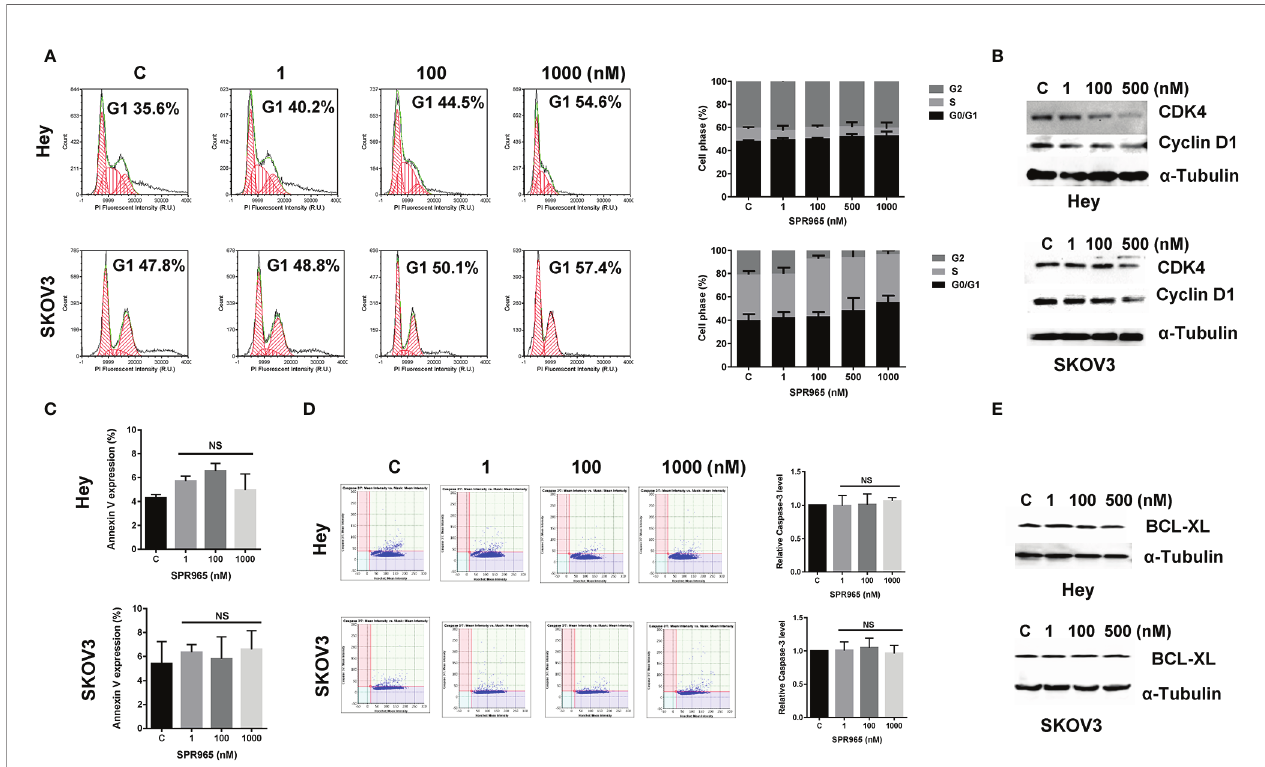
FIGURE 2 | Effect of SPR965 on cell cycle and apoptosis in ovarian cancer cells. The Hey and SKOV3 cells were treated with the indicated doses of SPR965 for 24 h. Cell cycle progression was assessed by Celigo Image Cytometer. SPR965 induced cell cycle arrest in G1 phase in the Hey and SKOV3 cells (A) . Cell lysates from the Hey and SKOV3 cells were subjected to Western blotting analysis for the expression of CDK4 and Cyclin D1 (B) . The results from Celigo Image Cytometer showed that SPR965 did not increase the expression of Annexin V or the activity of cleaved caspase 3/7 in either cell line (C, D) . The fi gures represented three independent experiments. Western blotting analysis demonstrated that SPR965 did not affect the expression of BCL-XL in the Hey and SKOV3 cells after 24 h of treatment (E) . Data are representative of one of three repeats *p < 0.05 and **p <